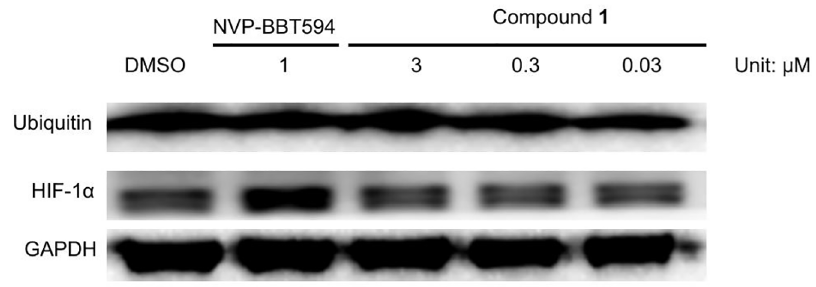
Fig 7. Effect of 1 on HIF1 α and ubiquitin in A375 cells. A375 cells were treated with the indicated concentrations of compound 1 (0.03 to 3 μ M) or positive control compound NVP-BBT594(1 μ M) for 24 h. Protein lysates were analysedby Western blotting with the